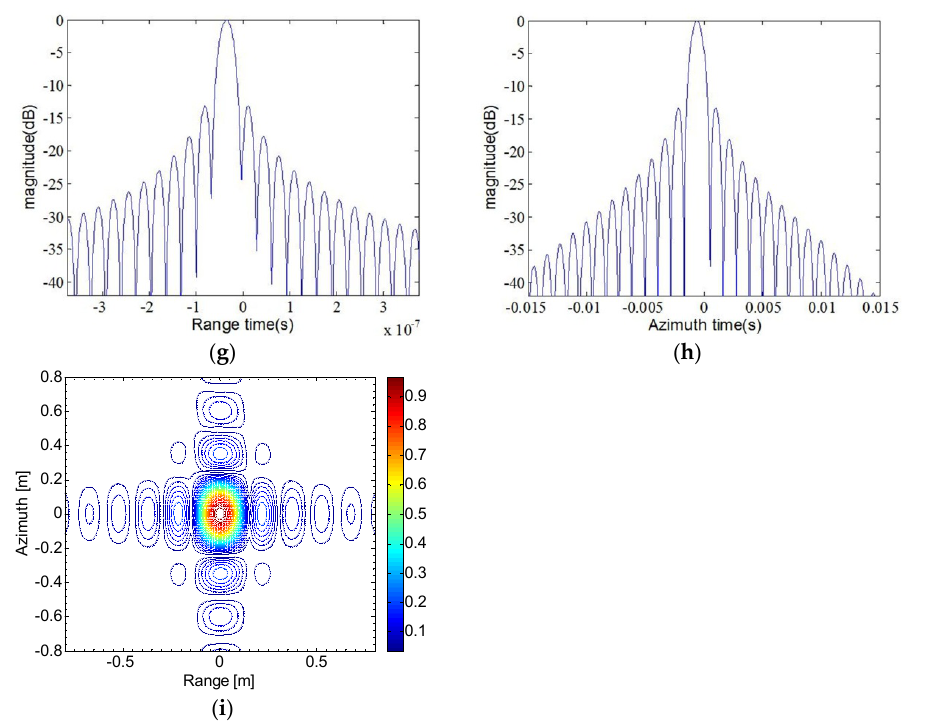
Figure 14 . Imaging results of P 3 , the point at the azimuth edge. Images ( a – i ) are in accordance with Figure 12. By applying resolution, peak to side lobe ratio (PSLR), and integrated side lobe ratio (ISLR) as